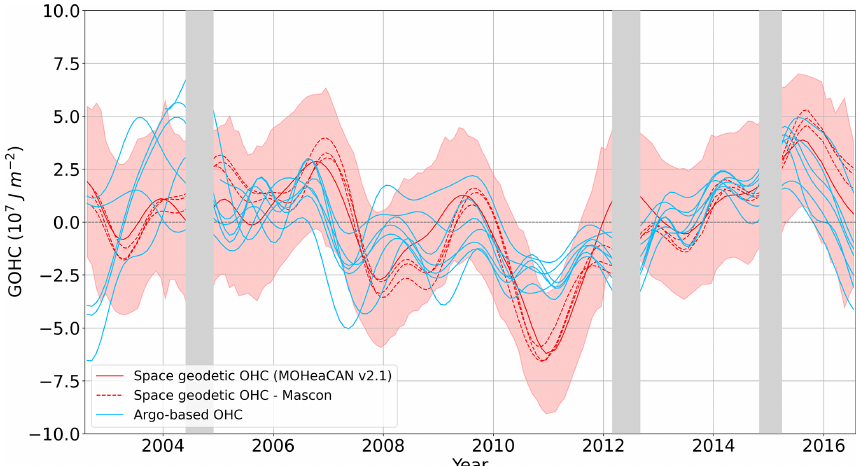
Figure 5. Interannual variations in global ocean heat content (GOHC) change. A 13-month low-pass filter is applied after removing periodic signals (annual and semi-annual) and trend. Red lines correspond to space geodetic estimates where estimates based on mascon ocean mass are represented as dashed lines and MOHeaCAN v2.1 is represented by the mean value (solid red) and the uncertainty at 1-sigma (shaded areas). Blue lines correspond to the Argo-based estimates from 2005. Grey areas correspond to the data gaps in the gravimetry product used for the space geodetic GOHC change.